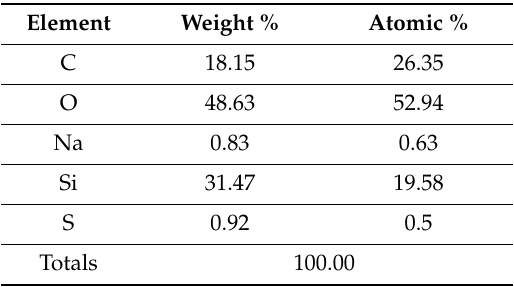
Table 1. EDS analysis of the prepared nano-SiO 2 · 0.5H 2 O